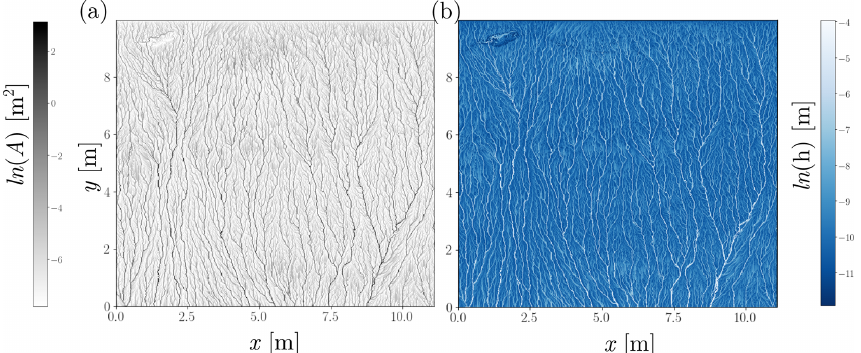
Figure 13. (a) Map of contributing area on half of the hillslope. Color scale is in log scale to make small rills visible and highlight the entire network. (b) Map of steady-state flow depths according to our numerical model. Color scale is in log scale.